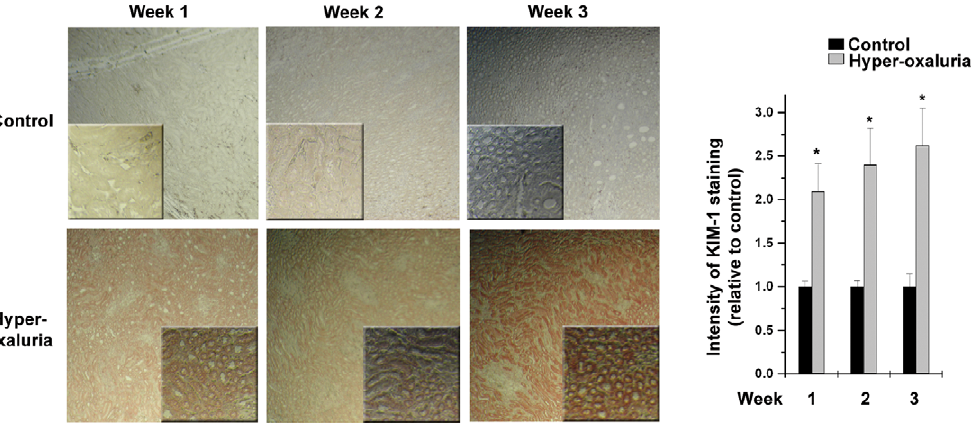
Figure 2. Immunohistochemical analysis of KIM-1 expression in kidney tissue of hyper-oxaluric rats. ( Left Panel ) KIM-1 protein expression in kidney tissue was detected using immunohistochemistry. ( Right Panel ) protein expression was quantified based on color density from five different 1 cm 2 regions of the section. Each data point represents mean + / 2 S.D. of two independent sections (* indicates p , 0.05 compared to control, n=2).